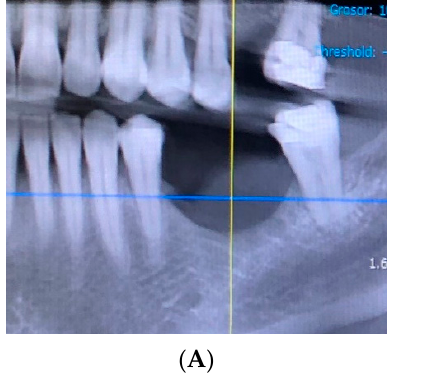
Figure 2. ( A , B ) Third quadrant CBCT measurements. ( C ) 3D mesh planning.